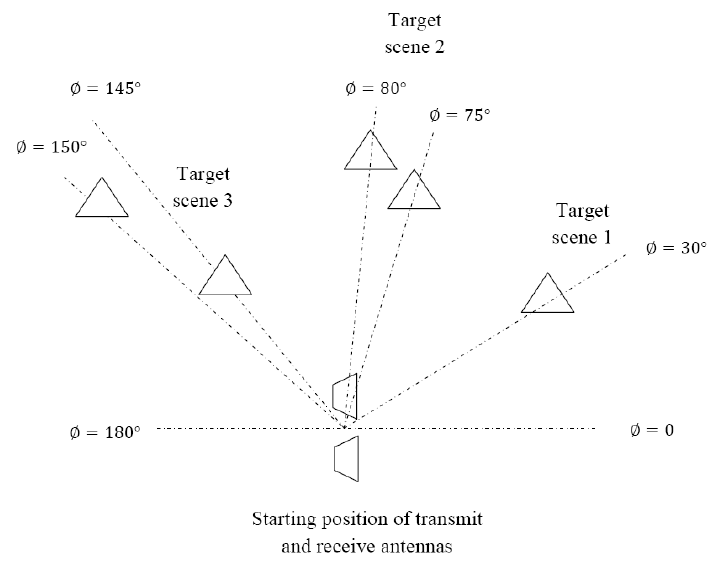
Figure 15. Diagrammatic representation of Target Scenario 7.